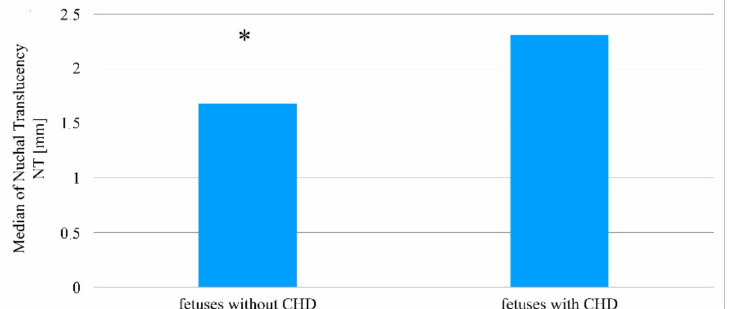
Figure 1. The thickness of the nuchal translucency in fetuses with and without a diagnosed congenital heart defect amongst patients who became pregnant without using assisted reproduction techniques. * Statistically significant difference (Mann–Whitney U test; p < 0.05).